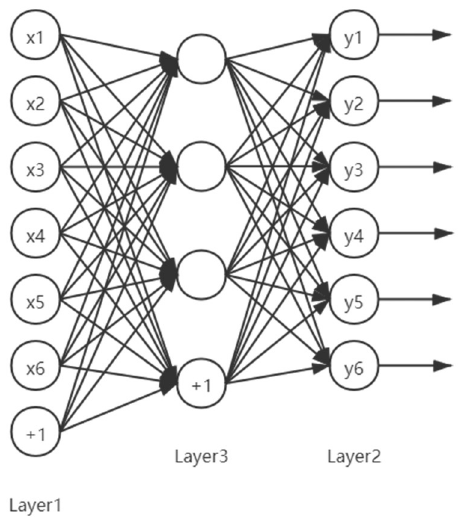
Figure 6. Autoencoder with the input layer neuron x and the output layer neuron y.